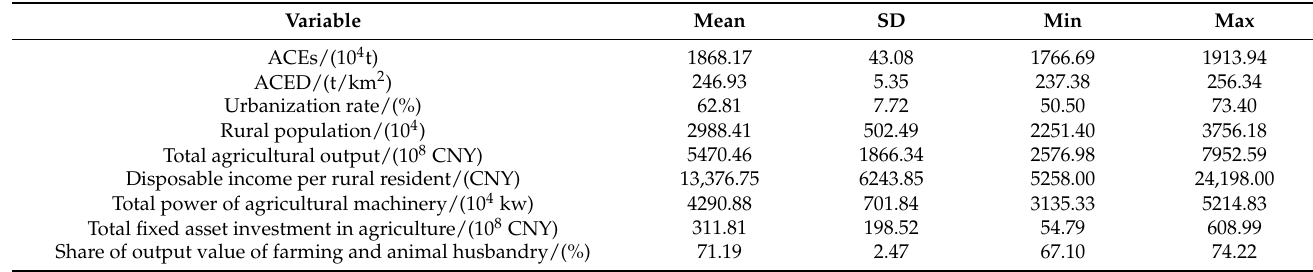
Table 1. Descriptive statistics of the main variables.